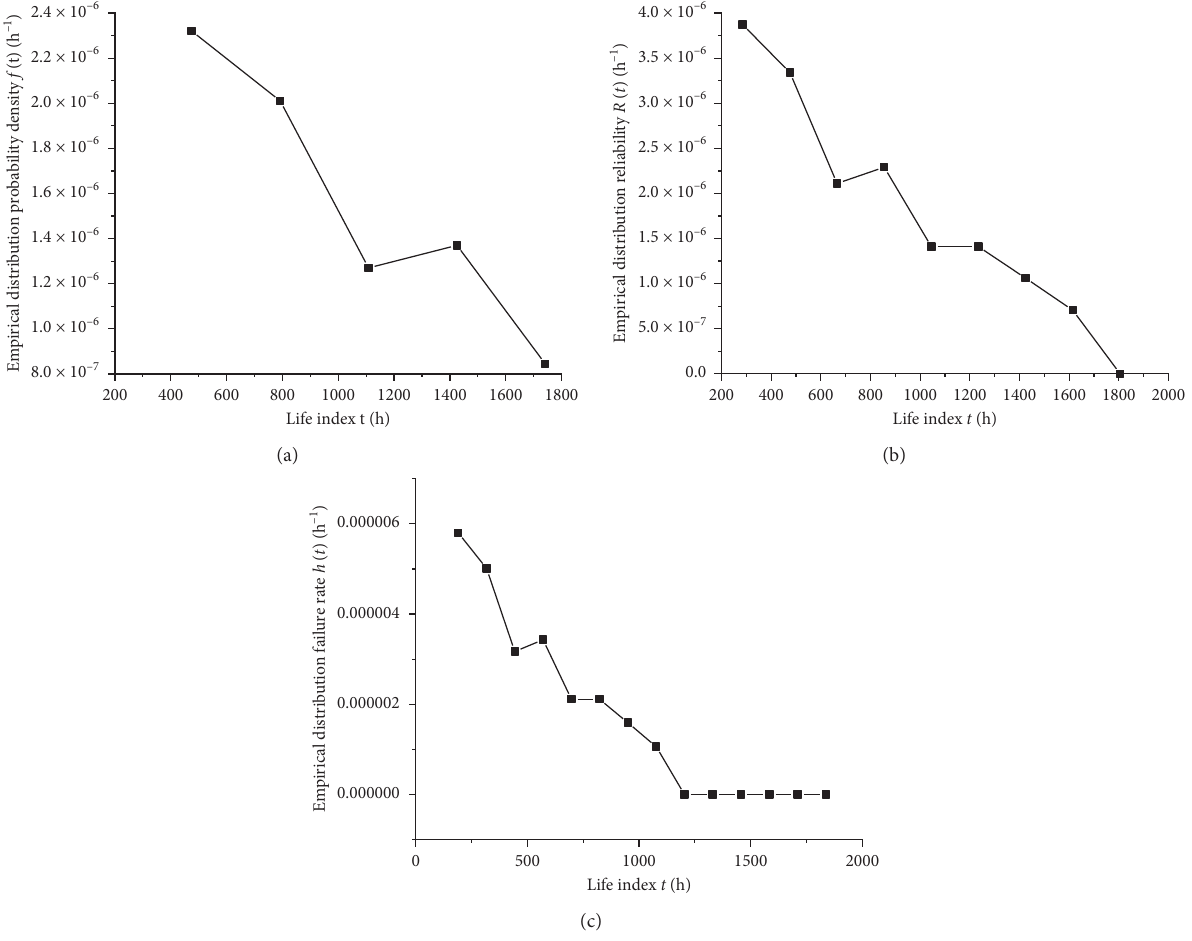
Figure 8: The failure rate varies with C . (a) Δ t � 316 . 55 ( n � 6). (b) Δ t � 189 . 93 ( n � 10). (c) Δ t � 126 . 62 ( n �